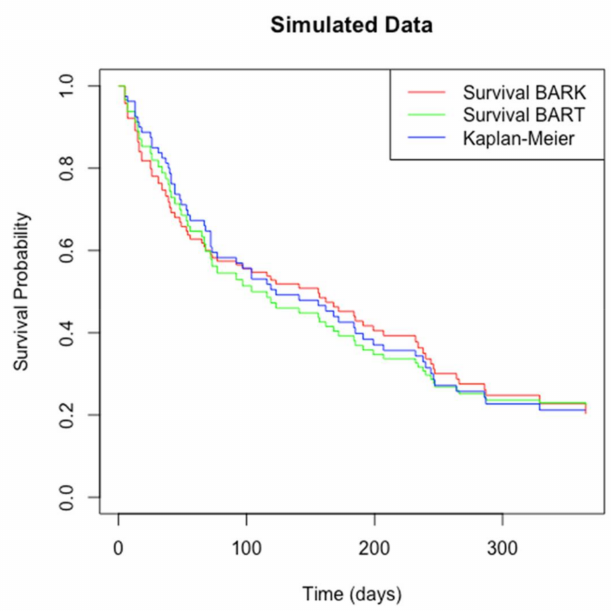
Figure 3. Estimated survival probability curves for the simulated dataset by nonparametric survival BARK, survival BART, and Kaplan–Meier